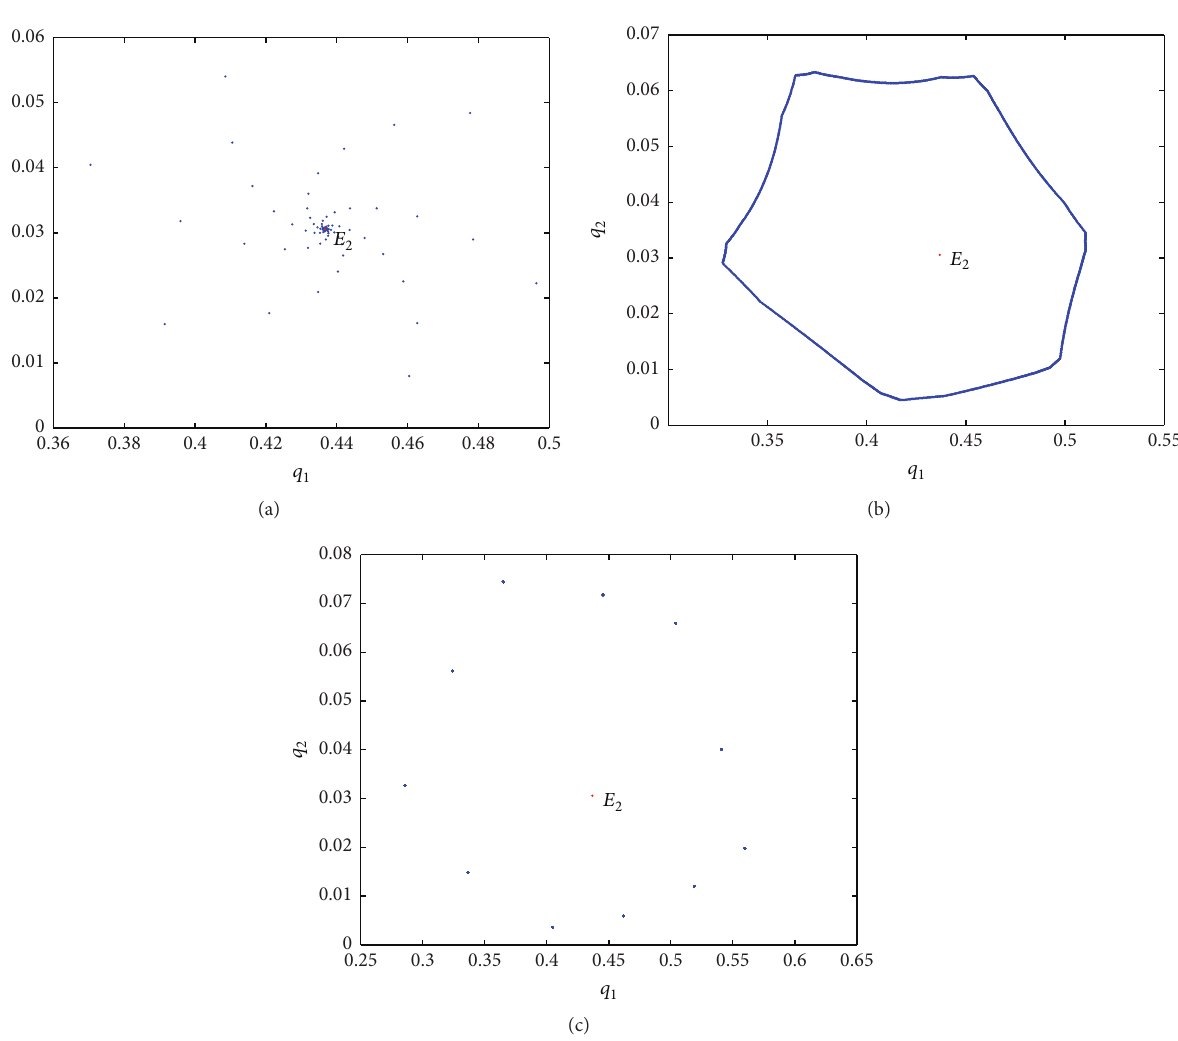
Figure 4: (a) Phase portrait of map (8) for V 1 = 0.3, V 2 = 0.7, 𝑐 1 = 0.14, 𝑐 2 = 2 . (b) Phase portrait of map (8) for V 1 = 0.37, V 2 = 0.7, 𝑐 1 = = 2 . (c) Phase portrait of map (8) for V 0.14 , 𝑐 2